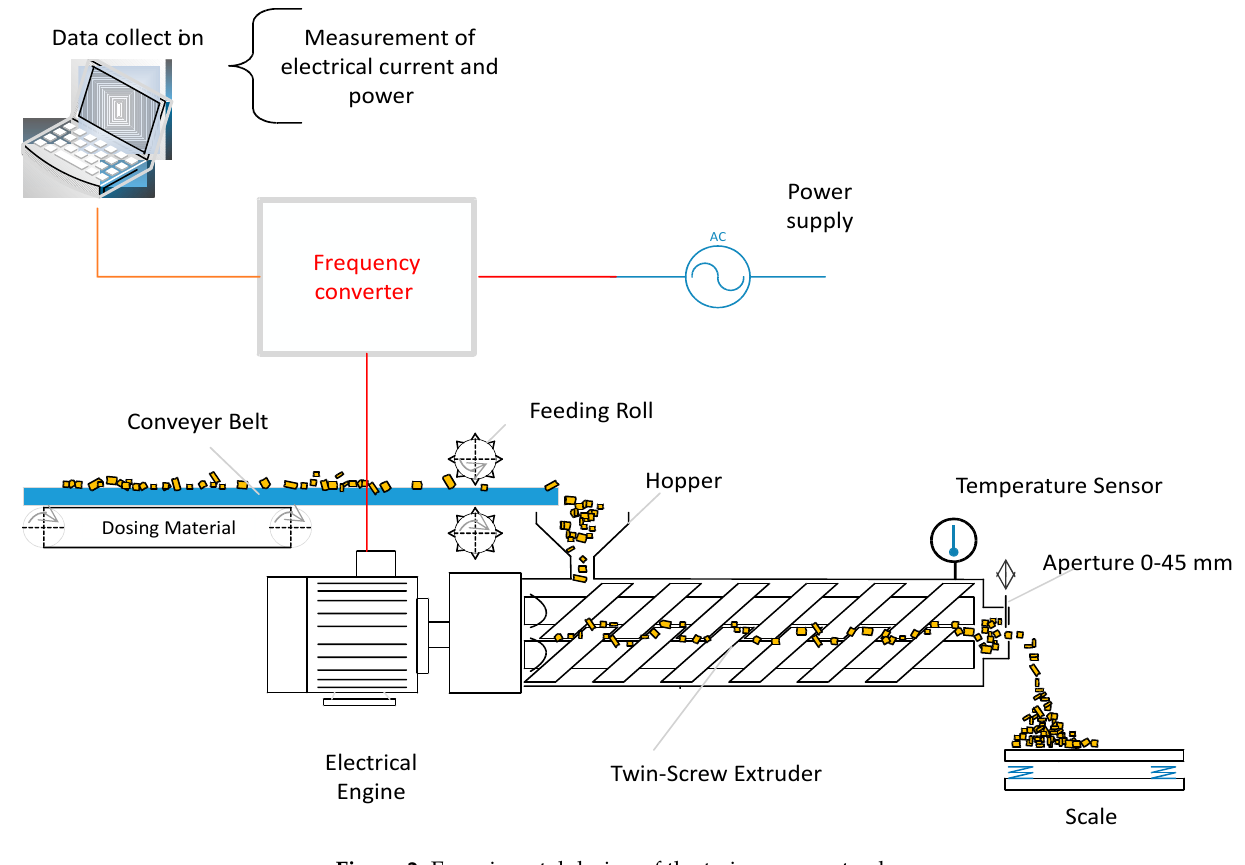
Figure 2. Experimental design of the twin-screw